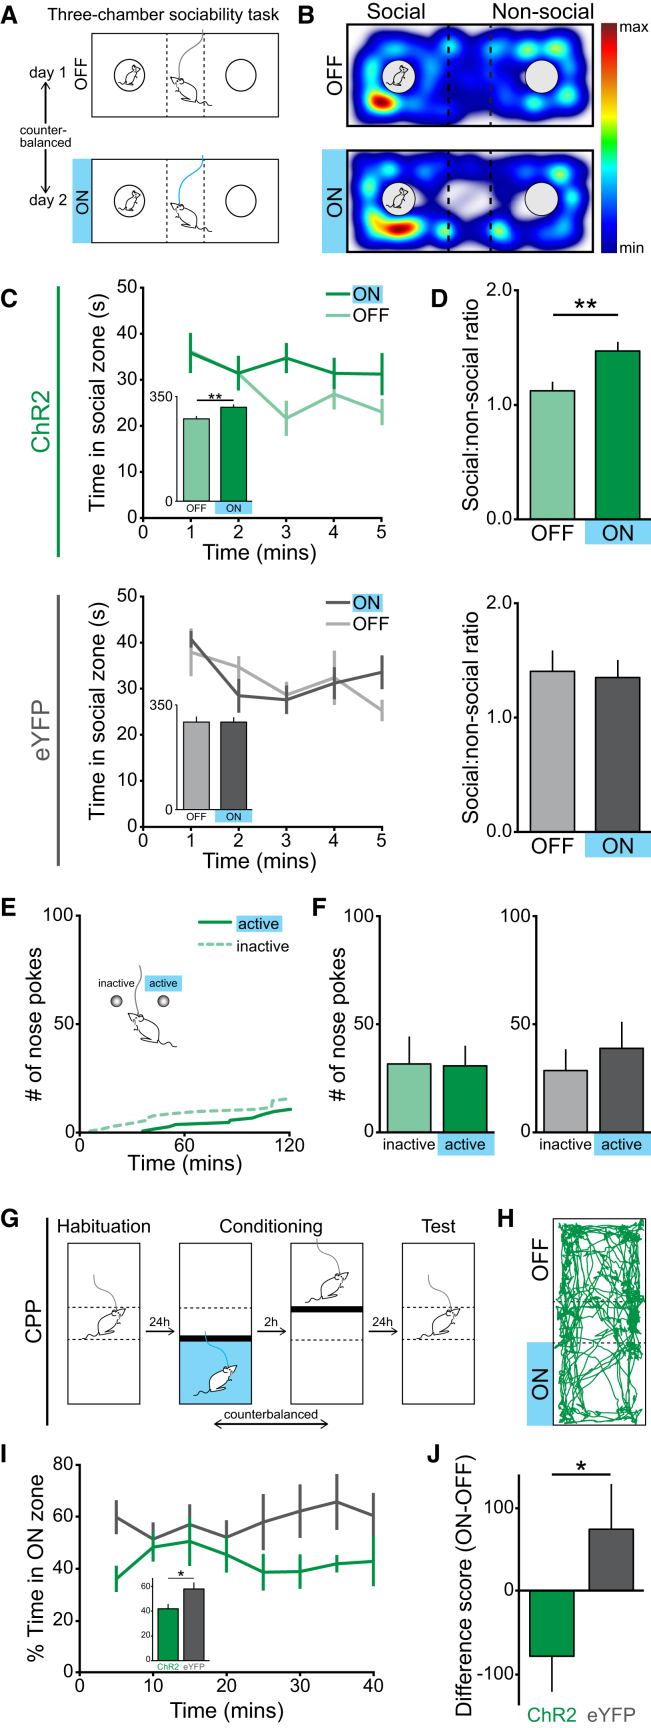
Optical Activation of DRN DA Neurons Elicits Social Preference and Place Avoidance(A) TH::Cre mice were tested for social preference in the three-chamber sociability task.(B) Representative spatial heat maps showing the location of a ChR2-expressing mouse.(C) Time spent by ChR2- and eYFP-expressing mice in the social zone across the first 5 min of the task, with and without photostimulation (inset shows total time). ChR2-expressing, but not eYFP-expressing, mice showed a significant increase in the total time spent in the social zone, relative to the non-social zone, when receiving blue light stimulation (ChR2, inset, paired t test: t10 = 3.297, ∗∗p = 0.0081, n = 11; eYFP: t10 = 0.0100, p = 0.9922; n = 11) and (D) a significant increase in the social:non-social ratio (ChR2, paired t test: t10 = 3.843, ∗∗p = 0.0032, n = 11; eYFP: t10 = 0.1847, p = 0.8572, n = 11).(E) Cumulative activity graph of nose pokes made by a ChR2-expressing mouse at the inactive and active (light-paired) ports during an ICSS task.(F) Optical stimulation of DRN DA neurons did not support ICSS, as revealed by the number of nose pokes made into the inactive and active ports by ChR2- (active versus inactive, paired t test: t4 = 0.0811, p = 0.9393, n = 5) and eYFP-expressing mice (active versus inactive, paired t test: t6 = 0.732, p = 0.4917, n = 7).(G) CPP paradigm and (H) representative track from a ChR2-expressing mouse during the first 10 min of the test session.(I) Graph showing % time spent in the previously light-paired zone (inset shows first 10 min). ChR2-expressing mice showed significant avoidance of the previously light-paired zone, relative to eYFP mice, as shown by the % time spent in this zone (unpaired t test: t10 = 2.393, ∗p = 0.0378, n = 6 ChR2, 6 eYFP) and (J) the difference between the time spent in the previously light-paired and unpaired zones (unpaired t test: t10 = 2.241, ∗p = 0.0489, n = 6 ChR2, 6 eYFP).Data are represented as mean ± SEM. See also Figure S5.